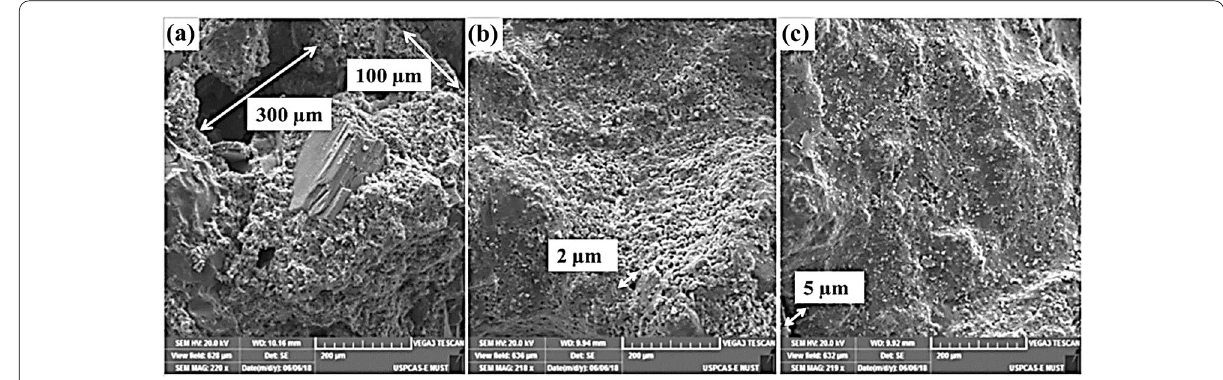
Fig. 11 Surface texture of granite dust incorporating AAC. a Control mix; b WGD20 and c WGD10 (Zafar et al.,